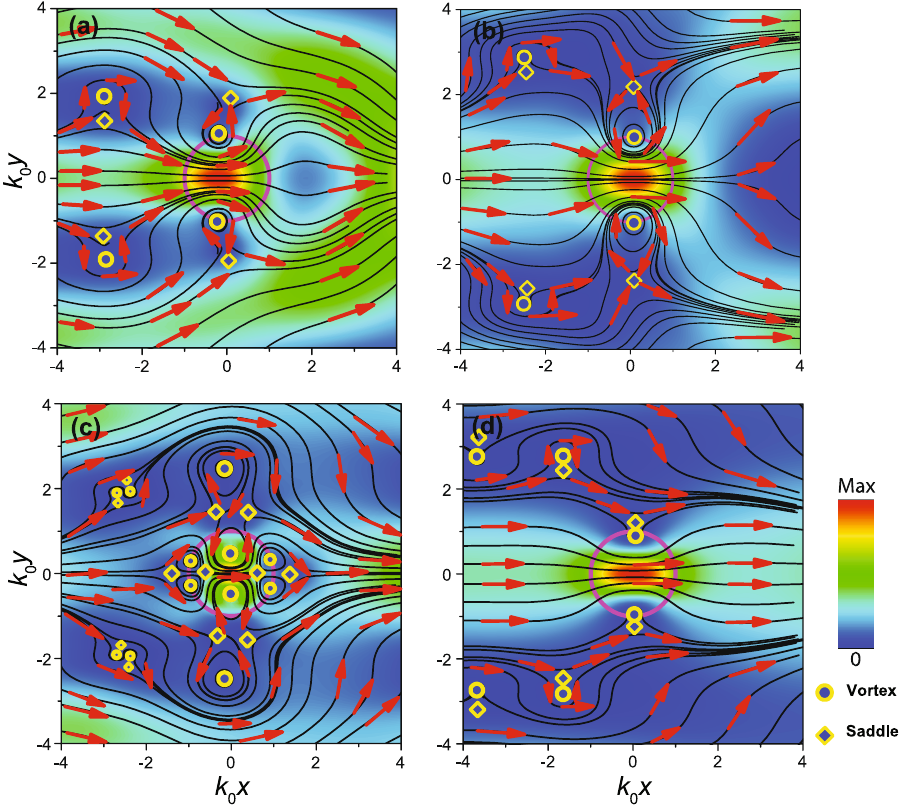
Figure 4. Poynting vector maps for ( a ) ε ′ = 6, α = 60° (optical force Colour and arrows indicate the magnitude | S | and direction S /| S | of the Poynting vector, respectively. Parameters: μ = 1, ε ″ = 0, k 0 R = 1, B =